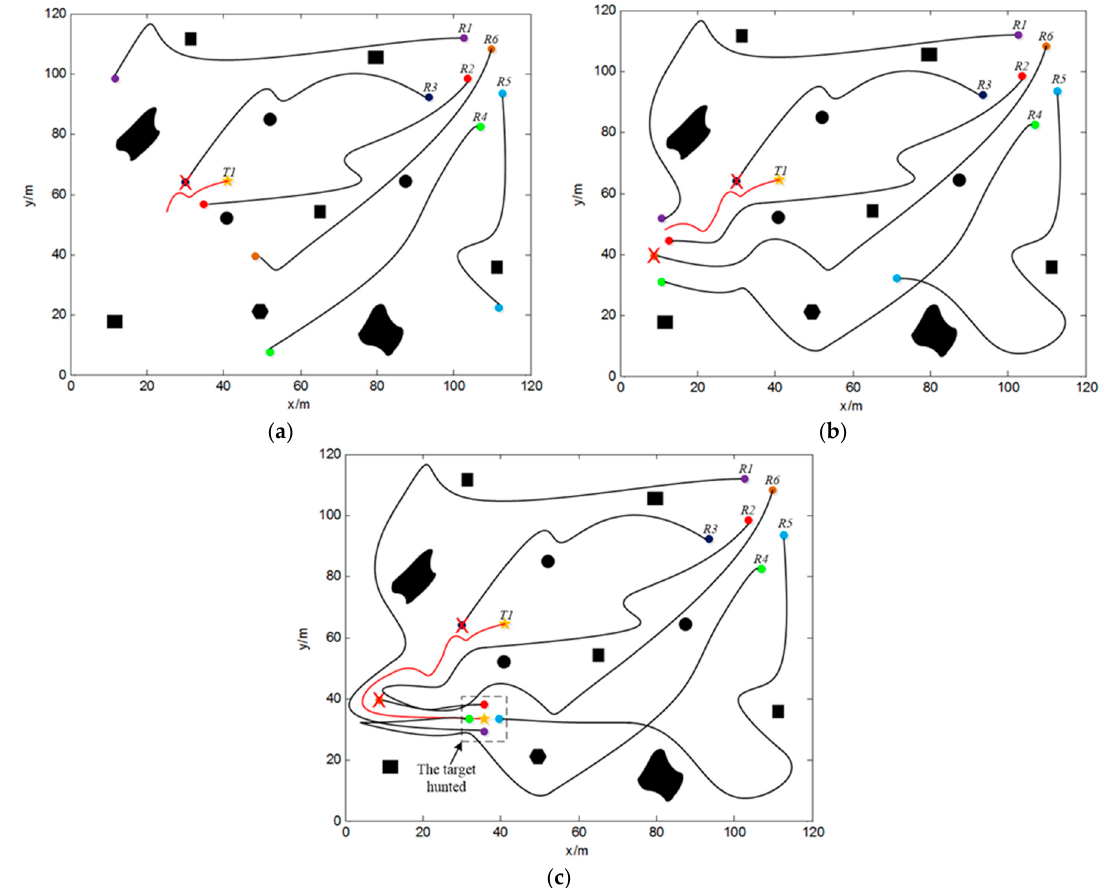
Figure 6. Search process when two AUVs break down. ( a ) The first AUV break down; ( b ) The second AUV breaks down; ( c ) Final trajectories of the whole hunting process.